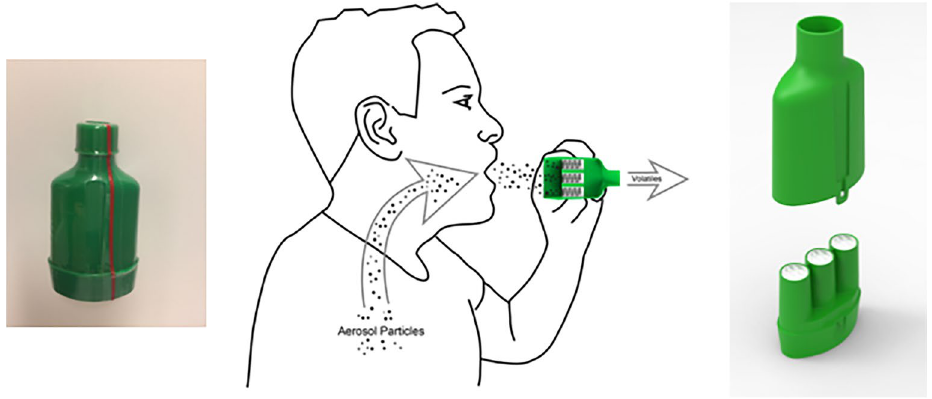
Figure 1. The BreathExplor device used for breath sampling (Munkplast, Uppsala). Before use, the plastic foil and inlet and outlet cups were removed (left). Participants were instructed to exhale 10 times through the device inlet. The device contained filters that collected aerosol particles from exhaled breath (middle). In the laboratory, microparticles were extracted from the filters and analyzed for the presence of illicit drugs using liquid chromatography and mass spectroscopy (right). The drawing was kindly provided by